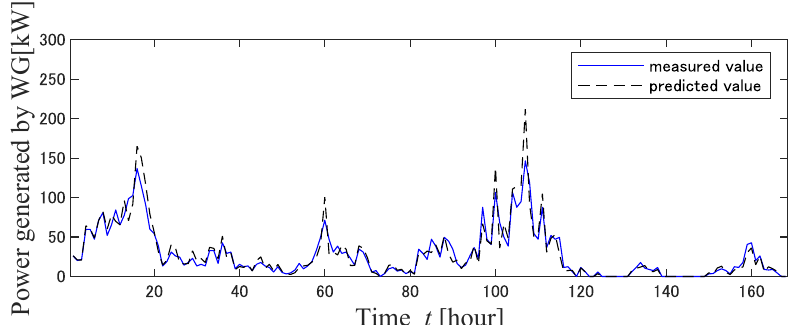
Figure 6. Power generated by WG (spring).